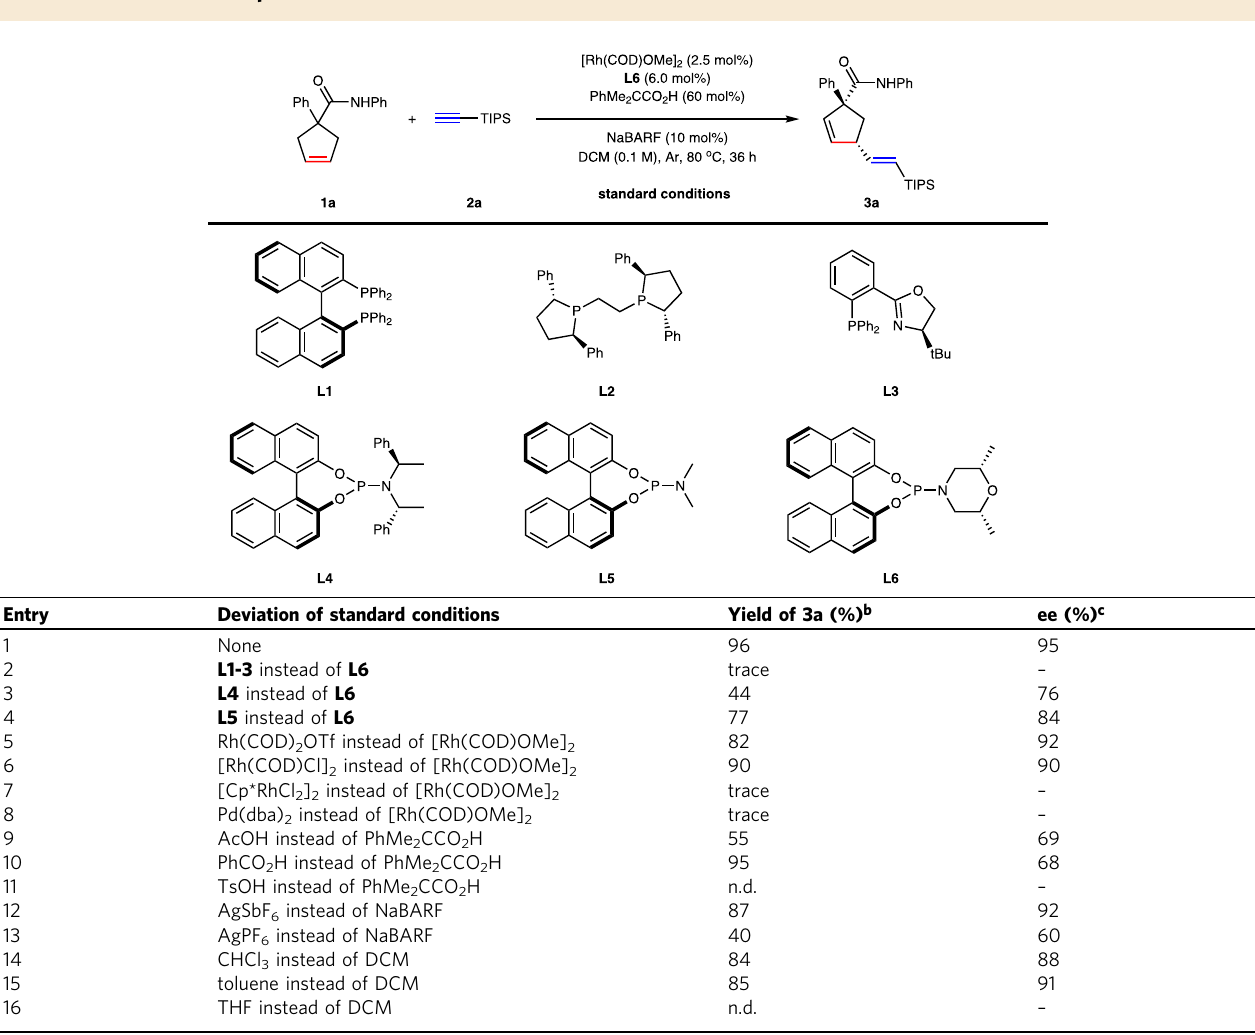
Table 1 Effect of reaction parameters a